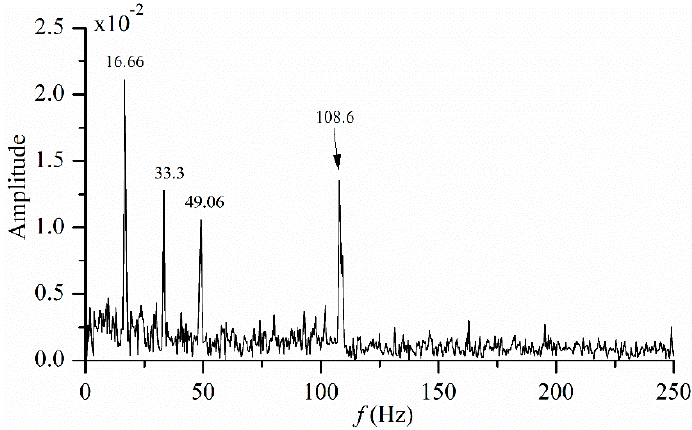
Figure 29. The Fast Fourier transform (FFT) of the acceleration signal.